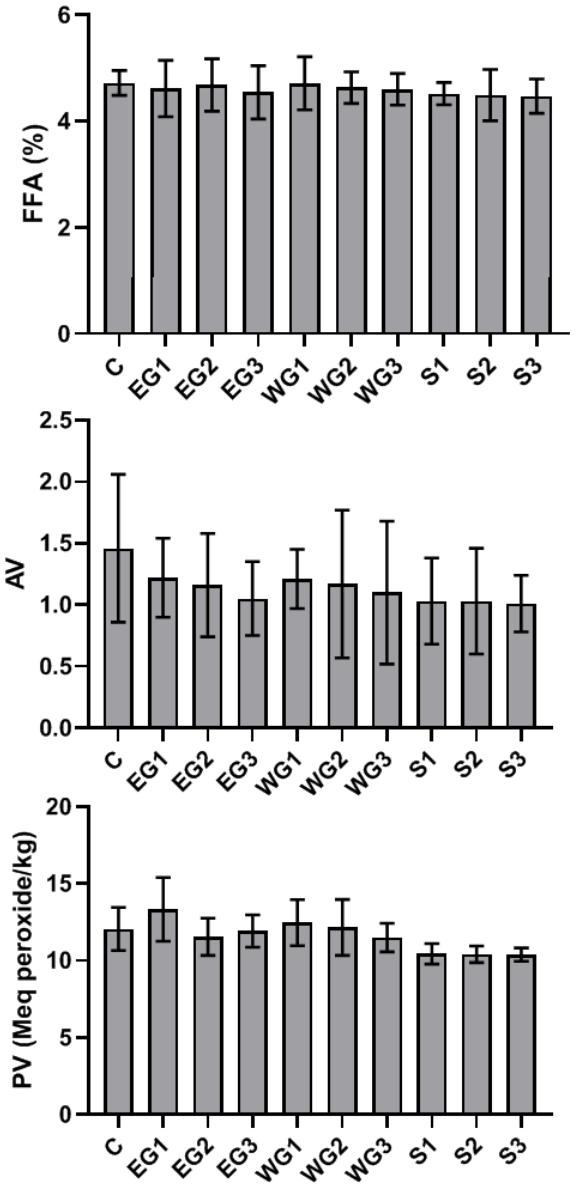
Figure 2. Chemical quality parameters of treated crude palm oil stored for one